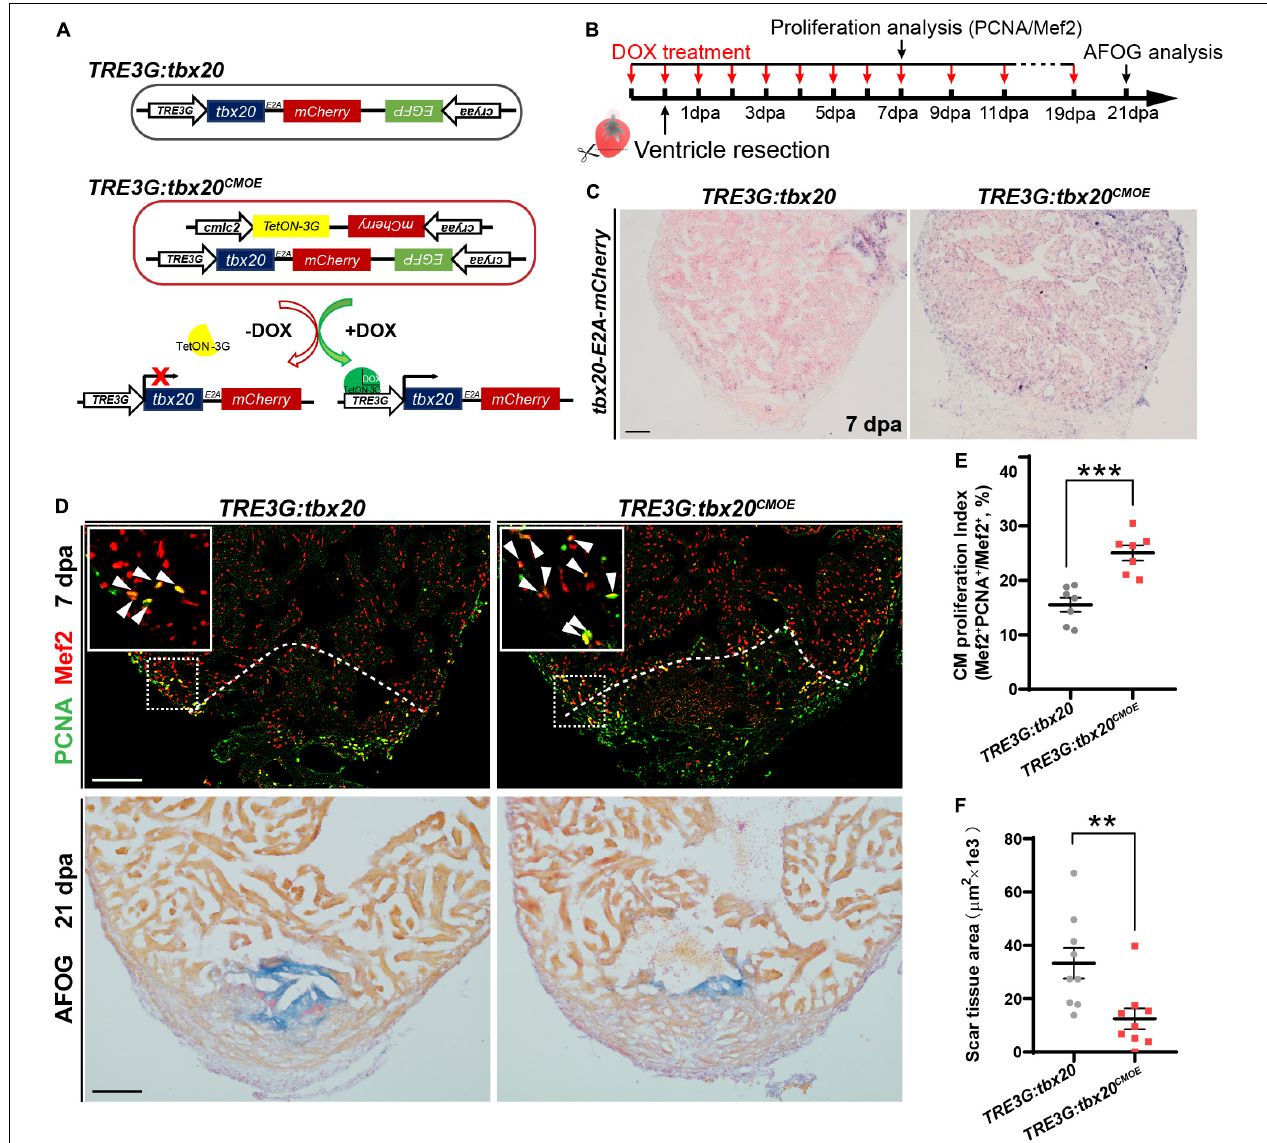
FIGURE 2 | Myocardial tbx20 overexpression in adult hearts promotes CM proliferation and reduces fibrotic scars. (A) Schematic diagram of transgenes of the control line Tg ( TRE3G:tbx20 ) and the inducible myocardial tbx20 overexpression line Tg ( TRE3G:tbx20 CMOE ) with DOX treatment. (B) Experimental strategy employed to induce myocardial tbx20 overexpression during heart regeneration. (C) Representative images of ISH with tbx20-E2A-mCherry probe on 7 dpa heart sections from DOX treated Tg ( TRE3G:tbx20 ) and Tg ( TRE3G:tbx20 CMOE ) fish. Scale bar: 100 µ m. (D) Upper panels: Representative confocal fluorescence images of heart sections from 7 dpa zebrafish immunostained for PCNA (green) and Mef2 (red). Insets showing high-magnification images of proliferating cardiomyocytes, arrowheads indicate PCNA + Mef2 + cells. Lower panels: Representative images of heart sections from 21 dpa fish stained with AFOG, muscle stained brown, collagen is blue and fibrin is red. The genotypes of fish were indicated above the images. Scale bar: 100 µ m. (E) Quantification of CM proliferation at border zone and injury site on 7 dpa heart sections ( n = 7 in each group). (F) Quantification of scar area at 21 dpa ( n = 9 in each group). The fish in (C–F) were treated with DOX as indicated in (B) . Each value in (E,F) represents mean ± SEM, ** p < 0.01, *** p <